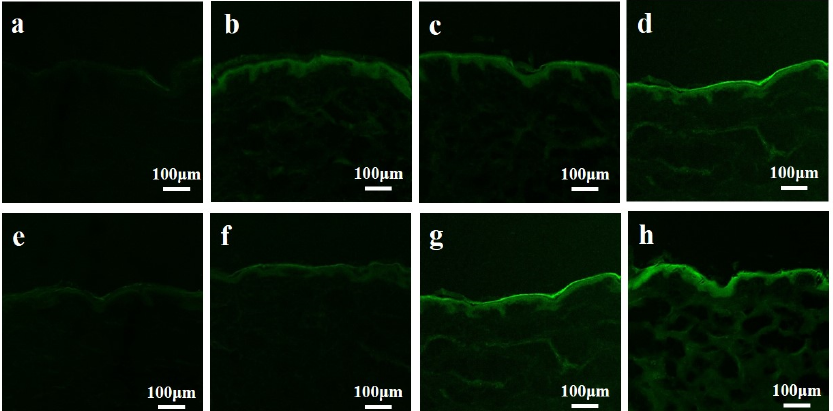
Figure 4. Confocal image of skin penetration of FITC-INS from ( a ) the control group; ( b ) 1.13 mg/cm 2 spicules treatment with 0.1 mg/mL FITC-INS; ( c ) 2.82 mg/cm 2 spicules treatment with 0.1 mg/mL FITC-INS; ( d ) 5.65 mg/cm 2 spicules treat- ment with 0.1 mg/mL FITC-INS; ( e ) the control group; ( f ) 5.65 mg/cm 2 spicules treatment with 0.05 mg/mL FITC-INS; ( g ) 5.65 mg/cm 2 spicules treatment with 0.1 mg/mL FITC-INS; ( h ) 5.65 mg/cm 2 spicules treatment with 0.2 mg/mL FITC-INS.